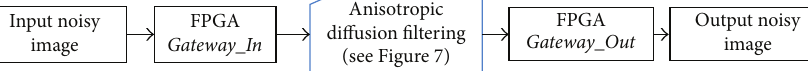
Figure 5: Work flow of design modules.